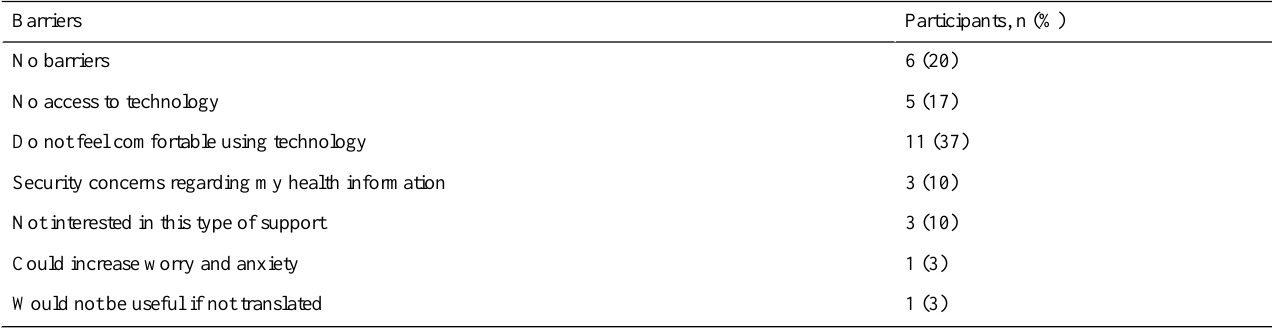
Table 2. Barriers to using a mobile pulmonary rehabilitation program